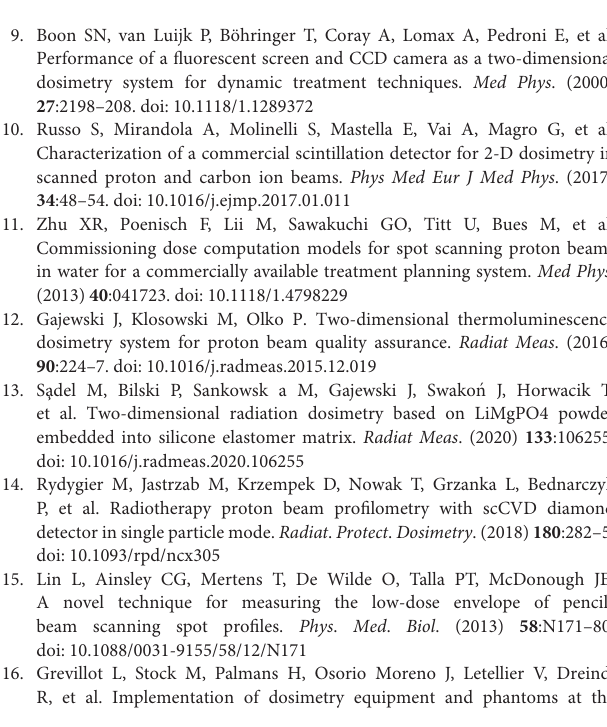
Supplementary Data Sheet 1 | PMMA holder technical sketch. Supplementary Data Sheet 2 | PMMA holder technical sketch. Supplementary Data Sheet 3 | PMMA holder technical sketch. Supplementary Data Sheet 4 | PMMA holder technical sketch. Supplementary Data Sheet 5 | PMMA holder technical